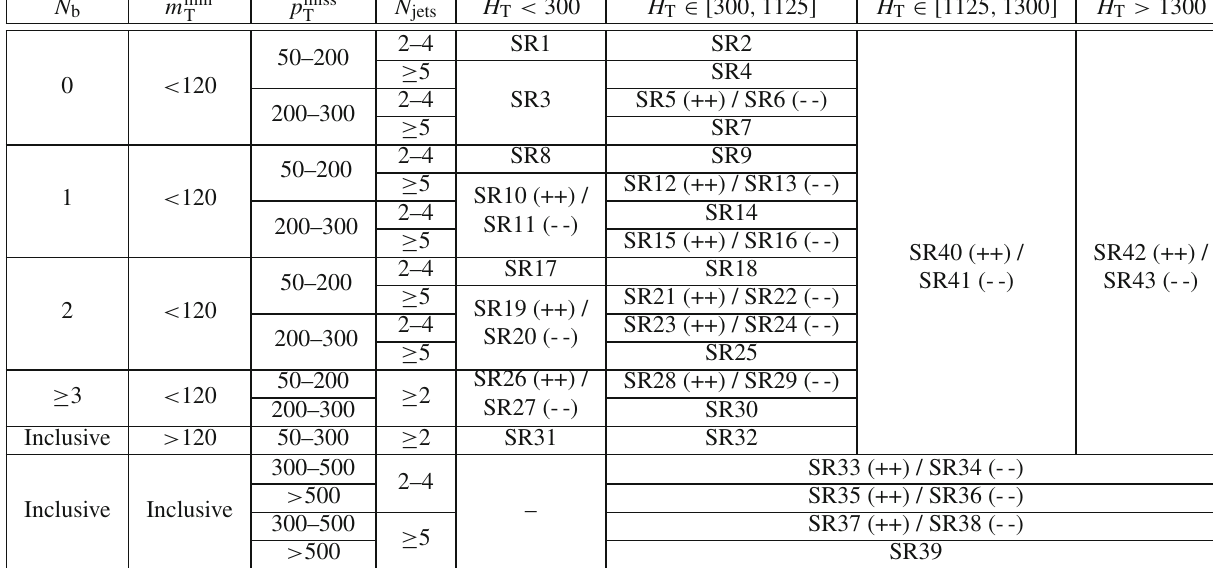
Table 3 The SR definitions for the HL category. Charge-split regions are indicated with (++) and (--). There are 43 regions in total. Quantities are specified in units of GeV where